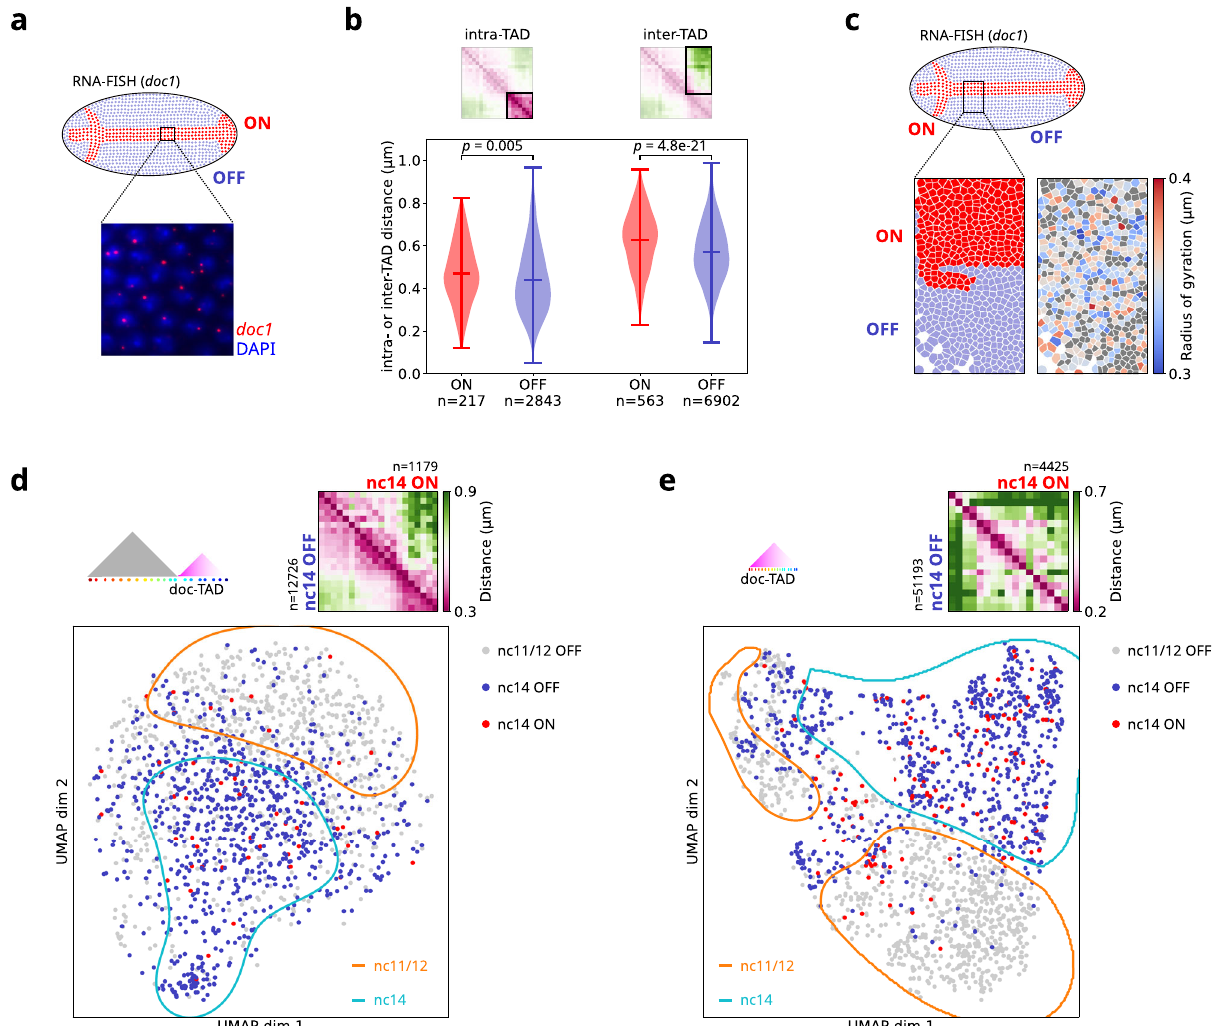
Fig. 3 | Transcriptionally active and inactive nuclei explore a similar con- formational space. a Top: scheme of a Drosophila embryo in dorsal orientation. Nuclei transcribing doc1 are indicated inred ( “ ON ” ), nucleinot transcribing doc1 in blue ( “ OFF ” ). Bottom: DAPI-stained nuclei (blue) with doc1 RNA-FISH spots indi- cating nascent transcripts (red). b Intra- and inter-TAD distance distributions shown as violin plots. For each nucleus, the median of the pairwise distances highlightedinthedistancemaponthetoparecalculated.Intra-TADdistanceswere calculated for the doc-TAD only, as shown on the region highlighted above. Dis- tances for ON nuclei are shown in red, distances for OFF nuclei in blue. Markers indicate the meanand extreme values of the distribution. Numberof nuclei ( n ) are indicated for all conditions. p -values calculated by a two-sided Welch ’ s t -test. c Bottom left: Cell masks after DAPI image segmentation from a Hi-M experiment. The color indicates the transcriptional state. Bottom right: The same masks as on